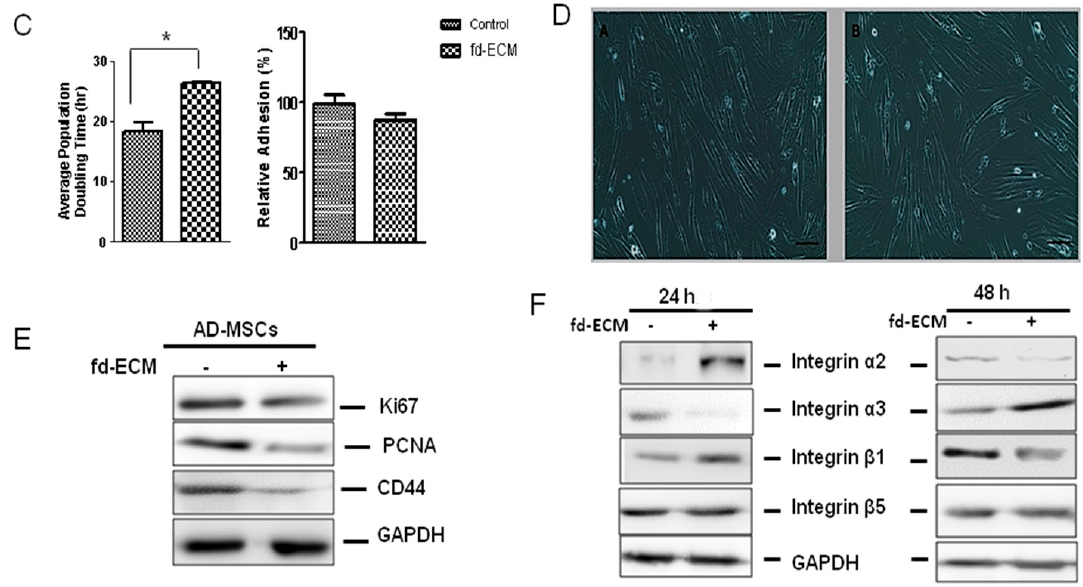
Figure 4. Fibroblast-derived extracellular matrix (Fd-ECM) reduces ad-MSCs proliferation. ( A ) Schematic representation of the experimental setup. Ad-MSCs were cultured on control plastic dishes ( ´ ) and on dishes containing fd-ECM (+); ( B ) Ad-MSCs were cultured on control dishes ( ´ ) and on the fd-ECM (+) for the indicated time periods. Control ad-MSCs ( ´ ) and those plated on fd-ECM (+) were counted at the indicated times using the Countess Cell Counter; ( C ) Average ad-MSCs population doubling time was calculated using the method described in “Materials and Methods Section 4.7”. Relative adhesion of ad-MSCs cultured on plastic dishes and on fd-ECM was evaluated and expressed as a percent of control cells. Each experiment was performed in triplicate; ( D ) Ad-MSCs were cultured on control dishes and on the fd-ECM for 48 h and cell images were taken using an Olympus CKX41 microscope. Scale bar: 25 µ m; ( E ) The expression of Ki67, proliferating cell nuclear antigen (PCNA), and CD44 decreased significantly in ad-MSCs cultured on fd-ECM (+) as determined by immunoblot analysis and ( F ) Immunoblot analysis of integrin α 2, α 3, β 1, and β 5 in ad-MSCs lysates after culture on plastic ( ´ ) and on fd-ECM (+) for 24 and 48 h. * p < 0.05.